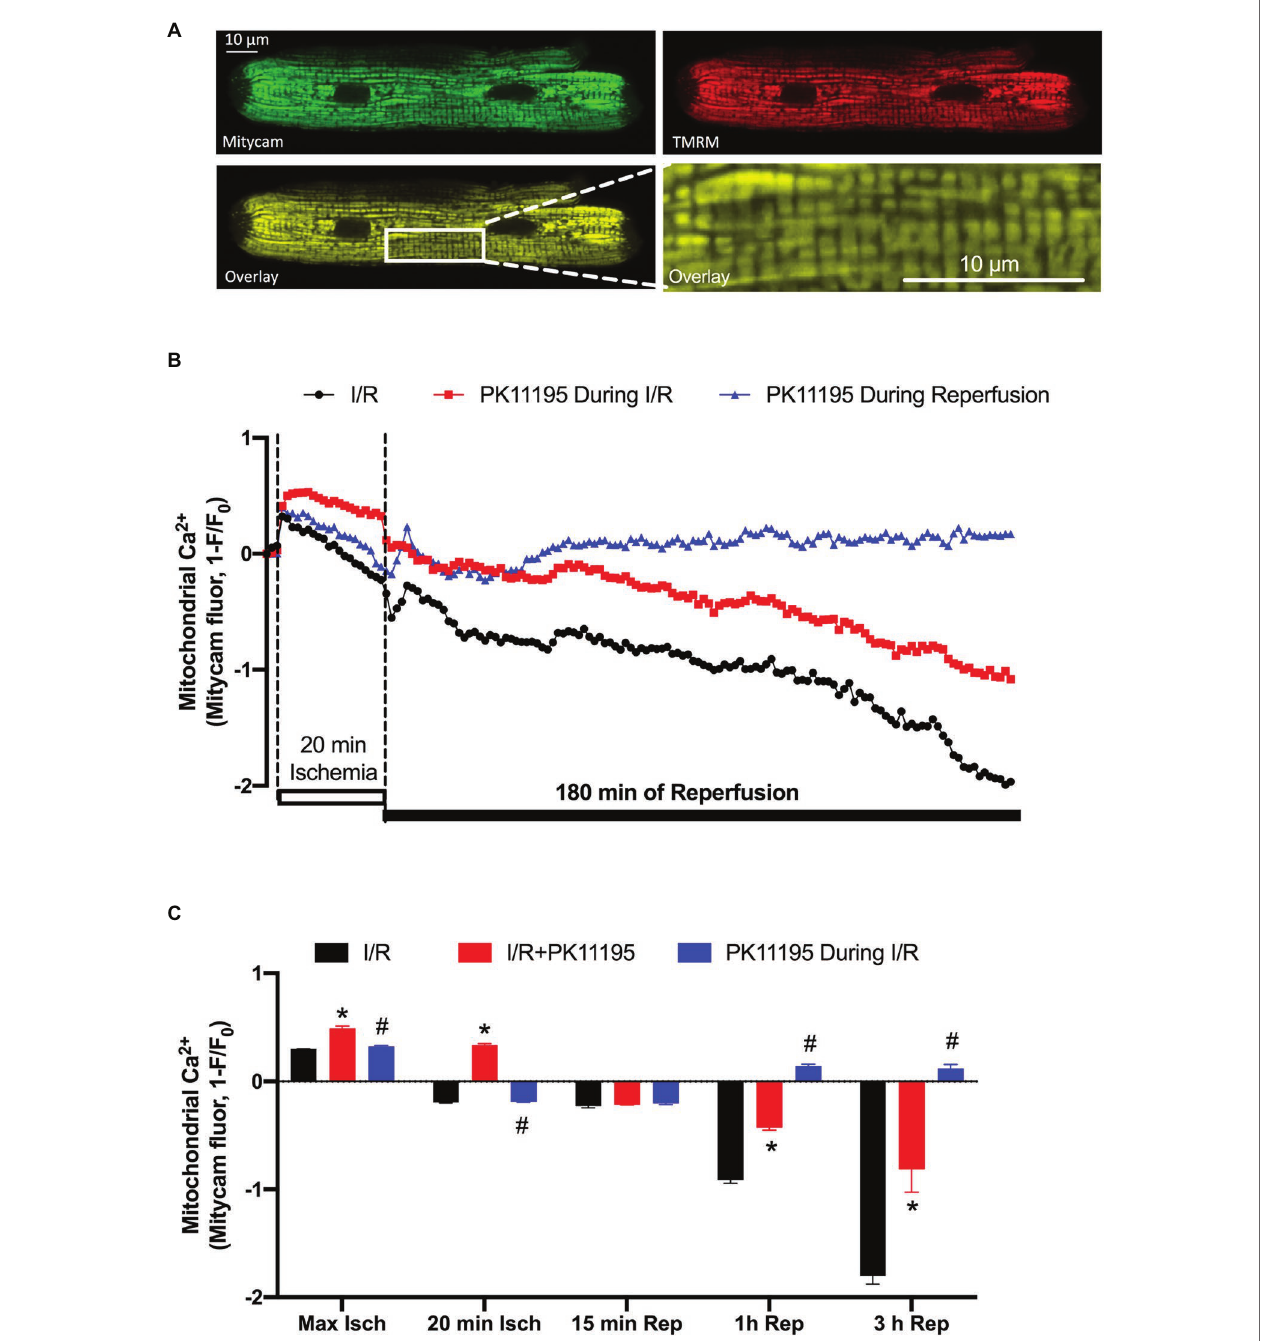
FIGURE 2 | Changes in mitochondrial Ca 2+ concentration ([Ca 2+ ] m ) during 20 min of simulated ischemia followed by 3 h of reperfusion. (A) Shown are the images of cardiomyocyte with expressed Ca 2+ -sensitive probe Mitycam (green) and loaded with 50 nM TMRM (red), and an overlay of both channels (yellow) confirming mitochondrial location of Ca 2+ protein sensor Mitycam. Expanded image on the right indicates enlarged mitochondrial region from the left image. (B) Changes in mitochondrial Ca 2+ during I/R monitored by Mitycam in the absence (black trace) or presence of 50 μ M PK11195 applied either during both ischemia and reperfusion (red trace) or only during reperfusion (blue trace). (C) Summary of mitochondrial Ca 2+ during I/R in the absence or presence of 50 μ M PK11195 applied during both I/R or only during reperfusion. Measurements were performed at the maximal [Ca 2+ ] m elevation in the beginning of ischemia (Max Isch), and in the end of 20 min ischemia, and 15 min, 1 h, and 3 h of reperfusion. Data expressed as mean ± SEM. n = number of cell preparations from 3 to 4 different animals per experimental group. * p < 0.05 reflects the difference between PK11195-treated cells vs. untreated cells exposed to I/R; # p < 0.05 reflects the difference between PK11195-treated cells applied during reperfusion vs. untreated cells exposed to